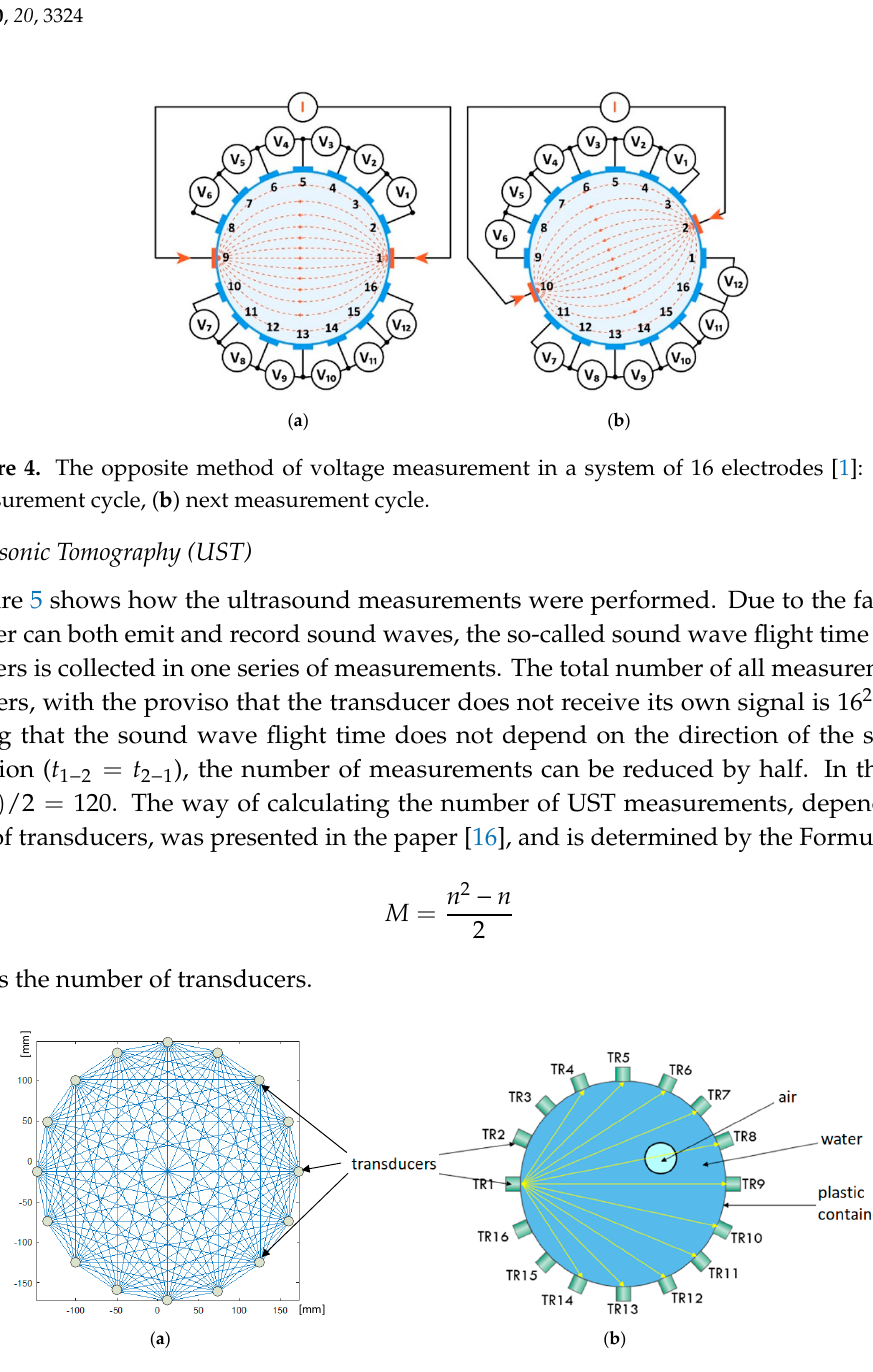
Figure 5. Principle of ultrasonic measurement using the transmission method: ( a ) the full grid of all UST signals, ( b ) signals emitted by a single transducer.